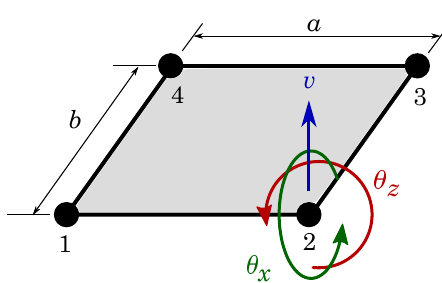
b with four nodes and 3 DOF in each node, the transverse ×